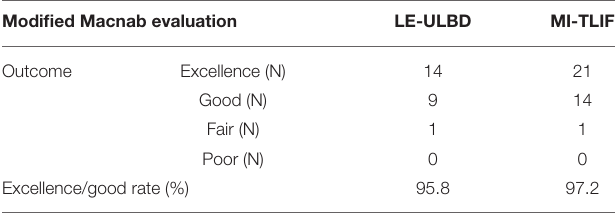
TABLE 5 | Comparison of modified Macnab evaluation in the two groups.